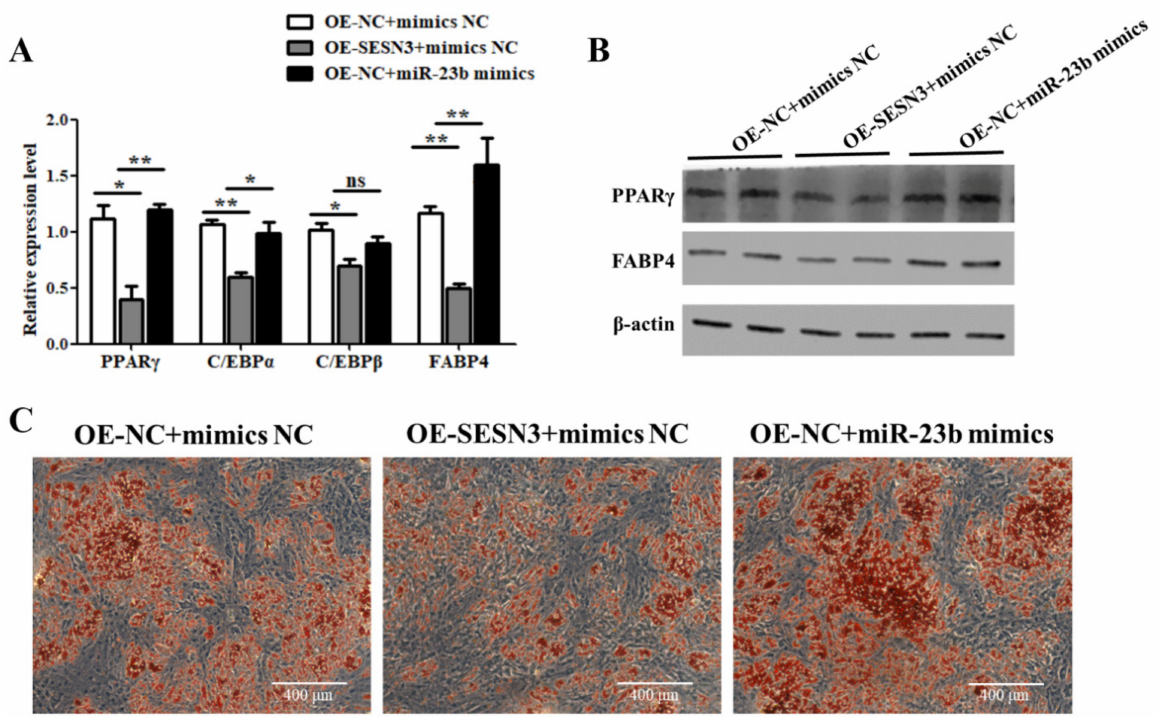
Figure 5. Recovery experiment of miR-23b and SESN3 . ( A , B ) The expression changes of adipogenic marker genes; ( C ) the results of Oil Red O staining. Note: * indicted significant difference at 0.05 level, and ** indicted significant difference at 0.01